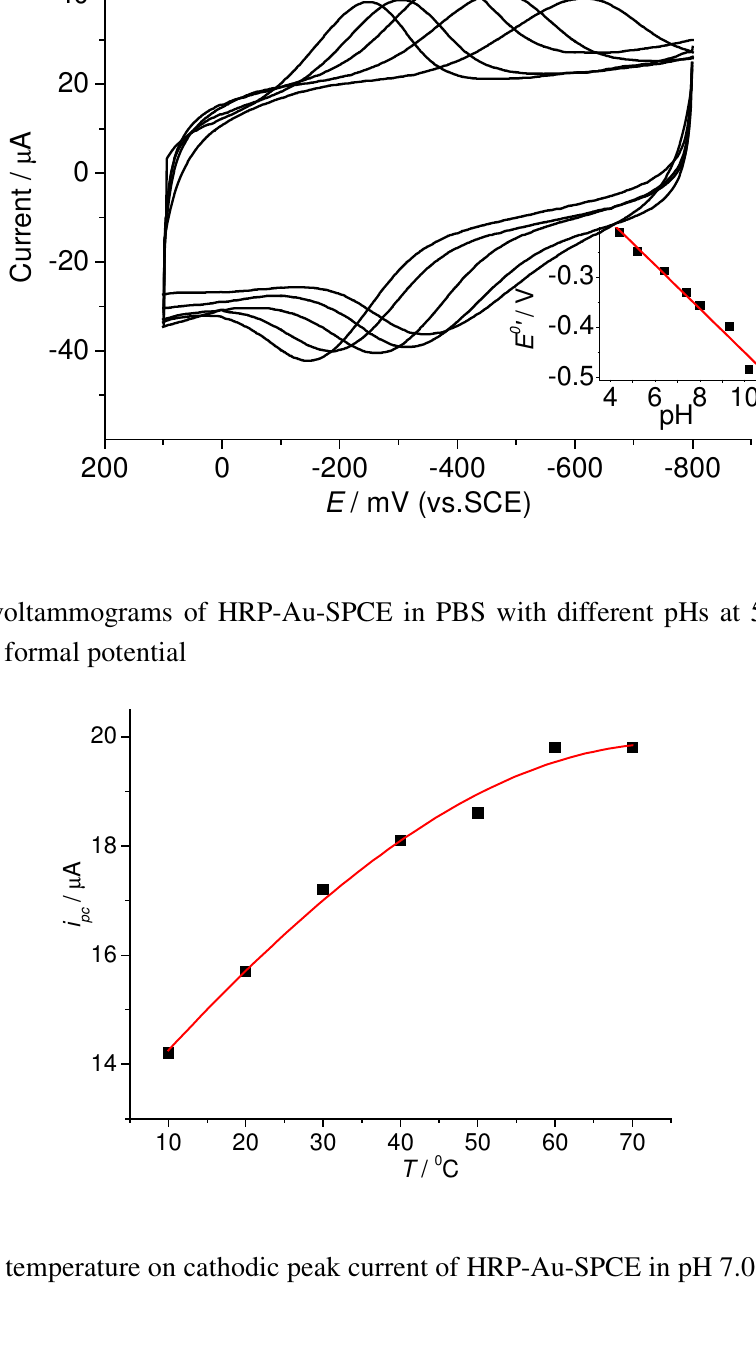
Amperometric response of the HRP-Au-SPCE to H